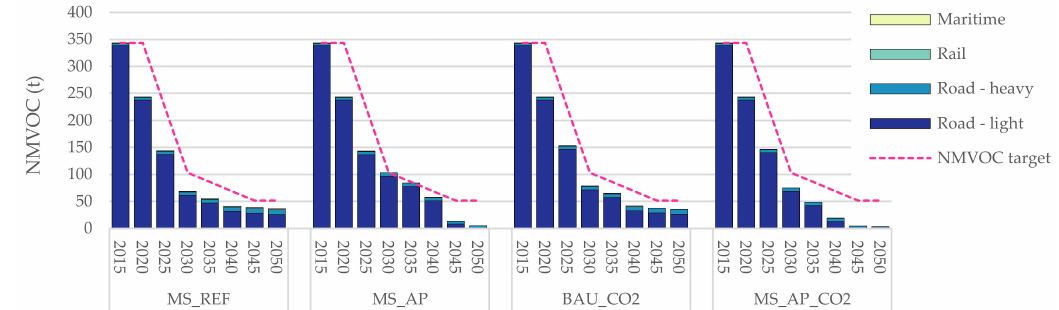
Figure A9. By-mode tailpipe emissions of non-methane volatile organic compounds (NMVOCs) in the mode shift (MS) scenarios (t). Note : Road—heavy = buses, MGVs and HGVs; Road—light = cars and